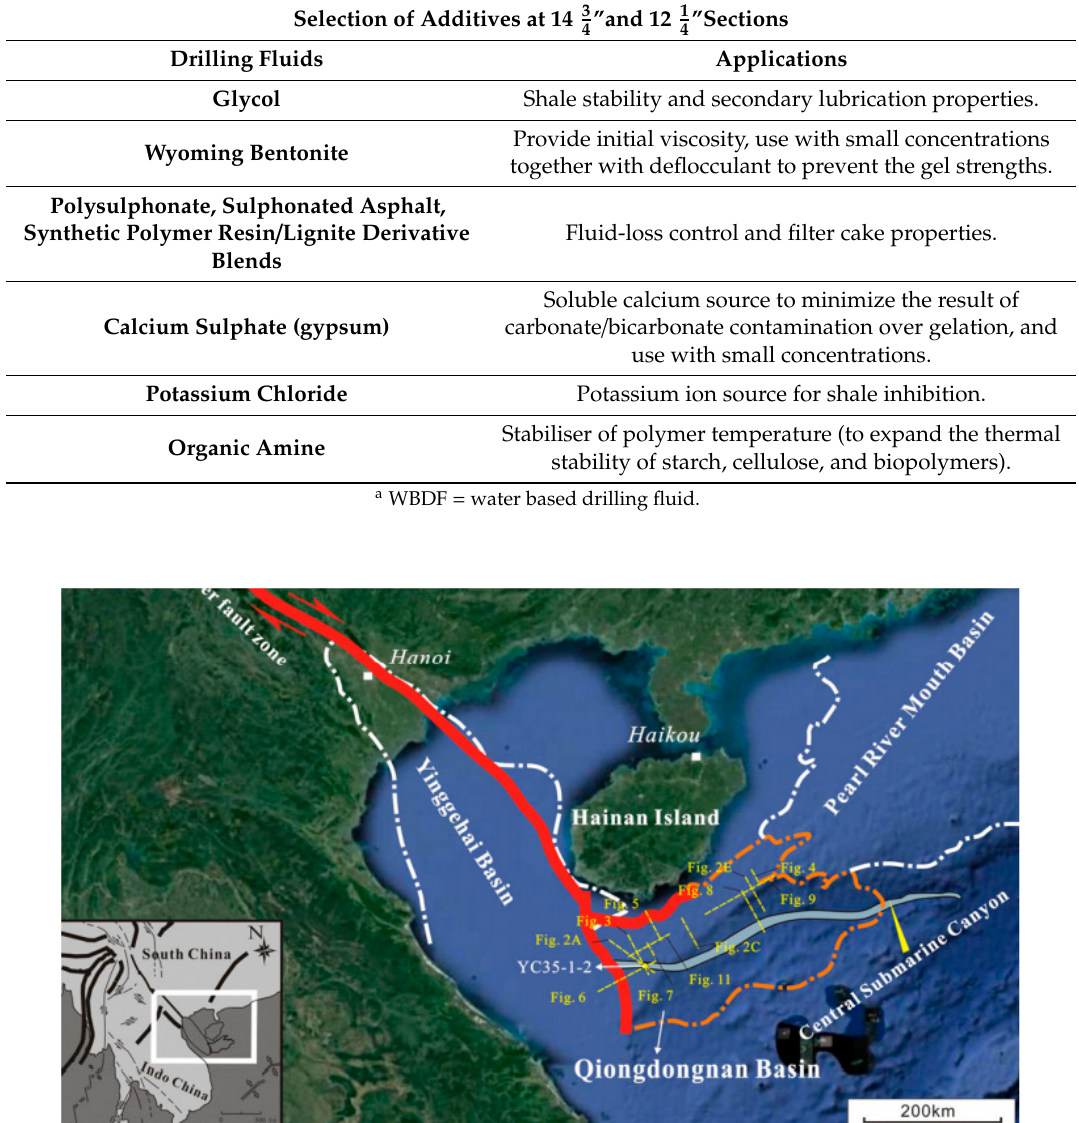
” and 12 1 ” sections. 4 4